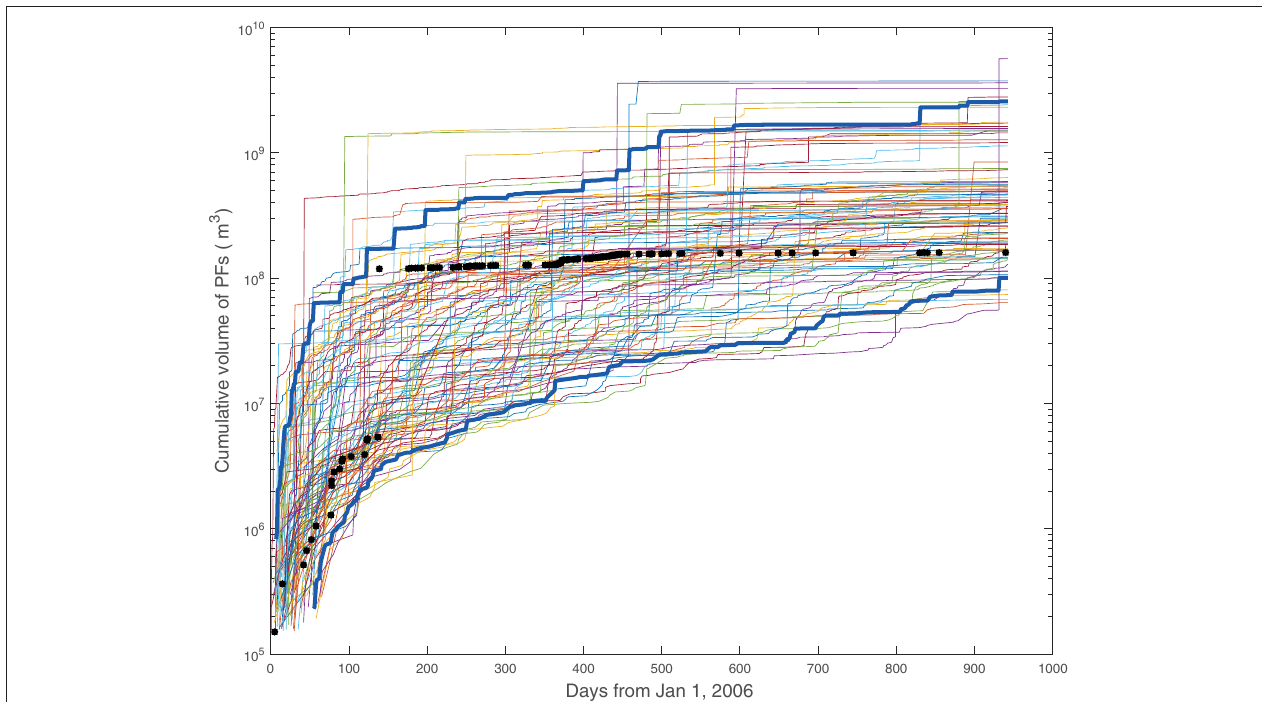
FIGURE 12 | Forecast activity, with data overlaid. Shows 100 forecasts of cumulative PDC volume in the period from 1 st January 2006 to 1 st August 2008, forecast using prior data. Asterisk symbols “ ” show realized cumulative volume. Thick blue lines show pointwise 90% prediction ∗